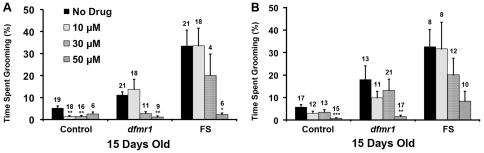
Dosage effects of reserpine on grooming.(A). Grooming activity of 15 day-old flies grown as larvae and maintained as adults on food containing no drug, 10, 30, or 50 µM reserpine (15 and 20 µM are omitted from figure). Reserpine suppresses grooming in dfmr1 and FS flies, but only at 50 µM; control flies show significantly reduced grooming at the lowest concentration, 10 µM. (B). 15 day-old flies treated with reserpine only as adults (i.e. larvae were grown on control food), show a similar response. Suppressed grooming in mutant flies is only significant at 50 µM. In contrast, reserpine significantly decreases grooming activity in control flies at 15 µM. Data are presented as the mean percentage of time single flies spent grooming during a 5 min period (Mean +/- SEM); sample sizes are displayed above each bar. For all data, *p<0.05 and ***p<0.001 (Kruskal-Wallis one-way ANOVA with Dunn's post-hoc comparison).